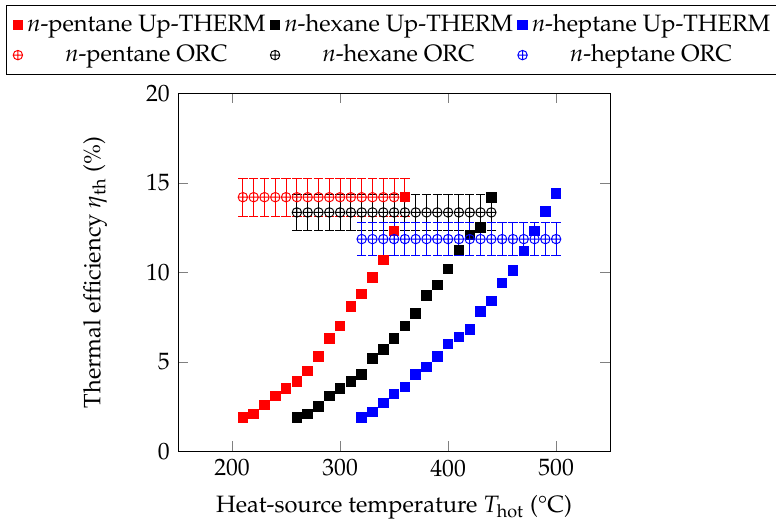
Figure 7. Thermal efficiency of the Up-THERM heat converter and equivalent ORC engines for different working fluids at different heat-source temperatures. For the ORC engines, the circles indicate an expander isentropic efficiency of 0.70 and the error bars isentropic efficiencies of 0.65 and 0.75,